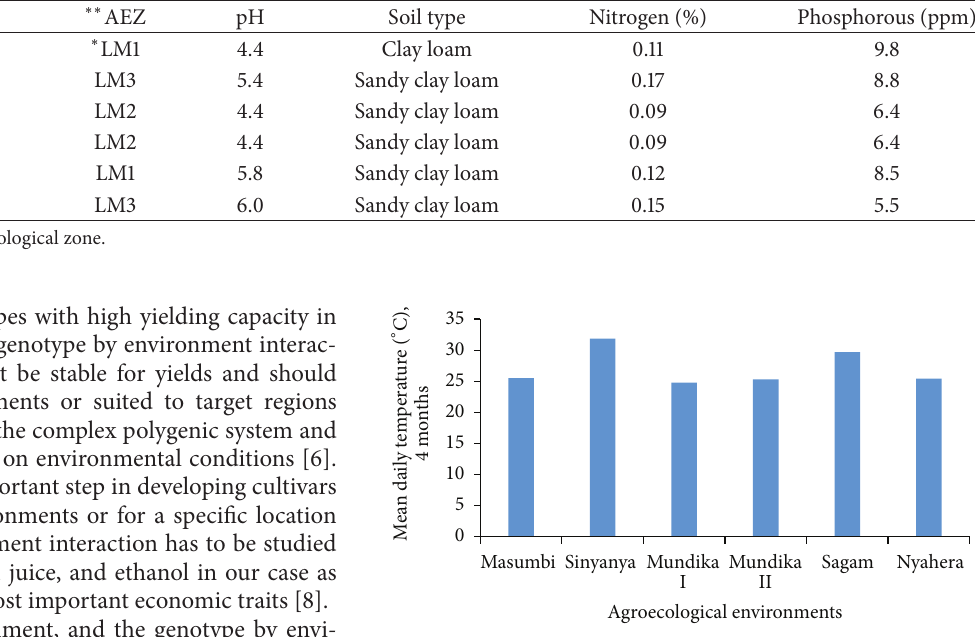
Figure 1: Mean daily temperature during sorghum growing